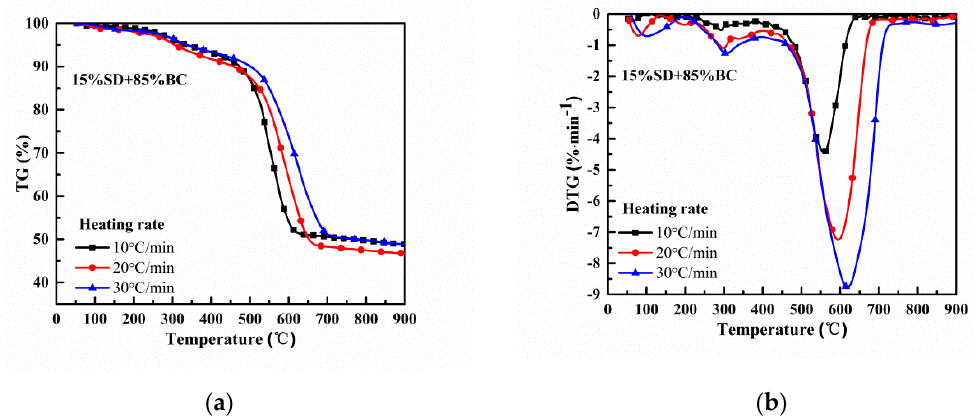
Figure 6. Thermo-gravimetric curves of experimental samples at different heating rates. ( a ) TG curve; ( b ) DTG curve.